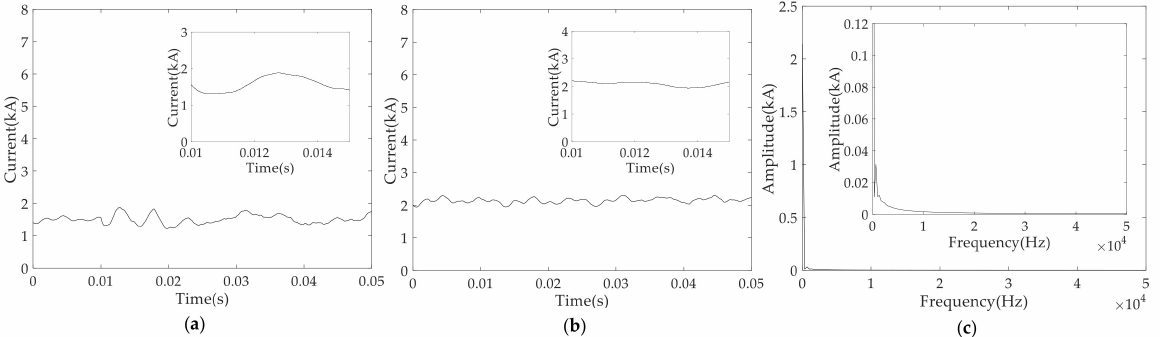
Figure 10. Fault characteristics of a single-phase grounding AC fault (AG-AC). ( a ) Current waveform; ( b ) current line mode component waveform; ( c ) spectrum